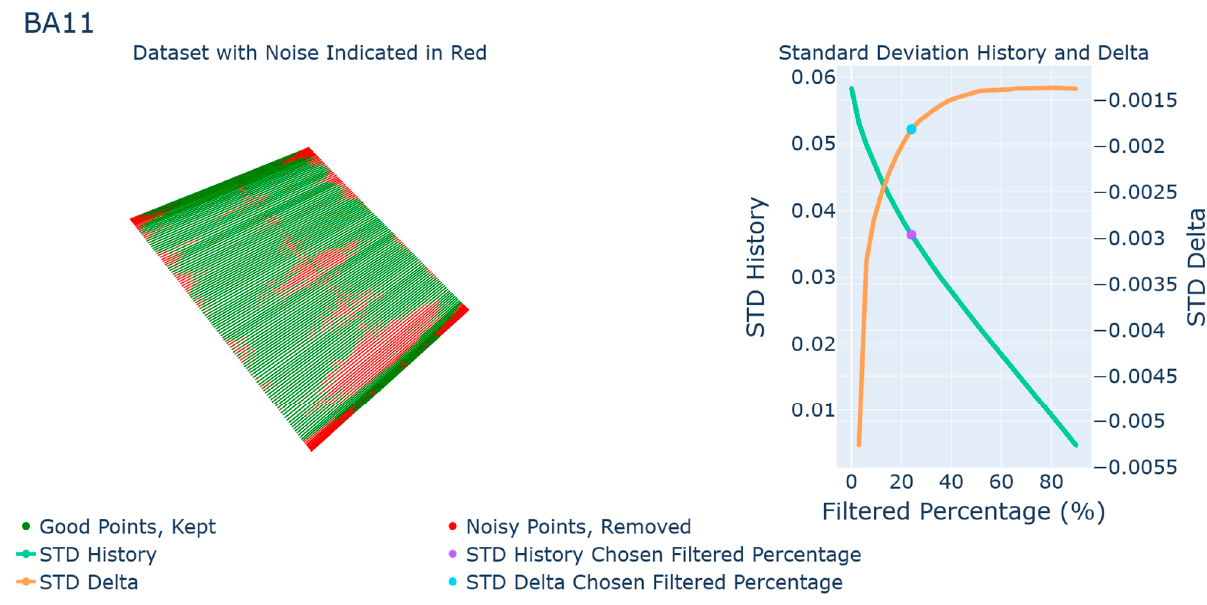
Figure 11. Results for the brushed aluminum part at +25 ◦